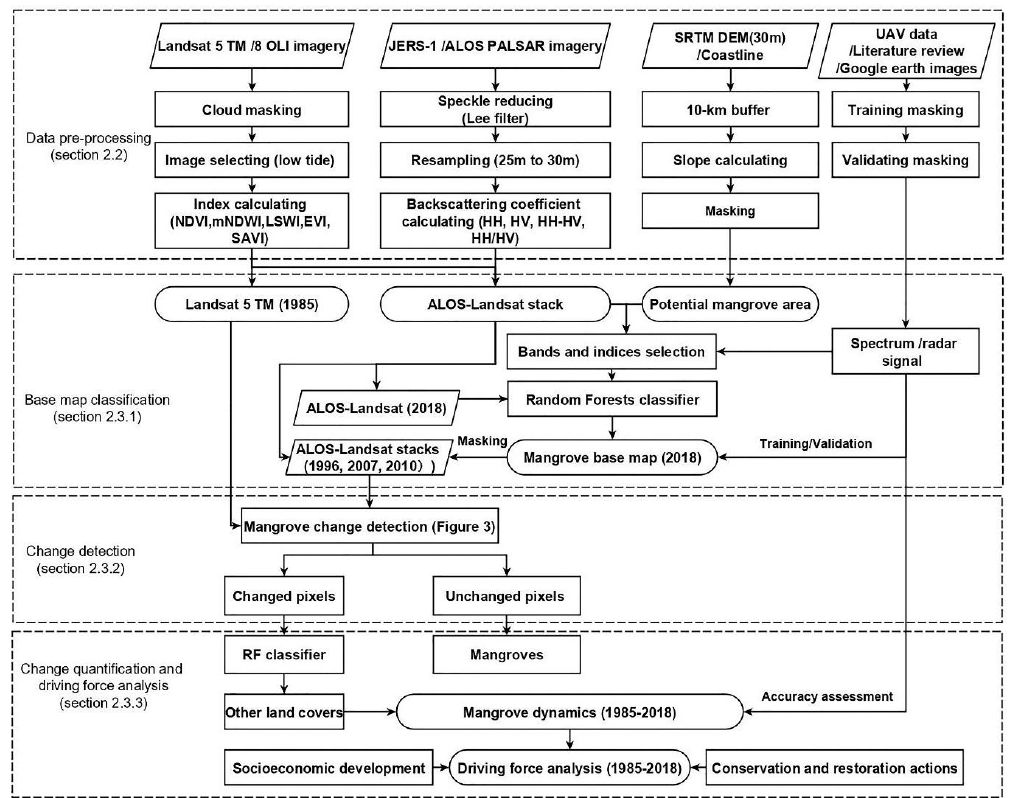
Figure 2. Flowchart of mangrove mapping and change detecting.